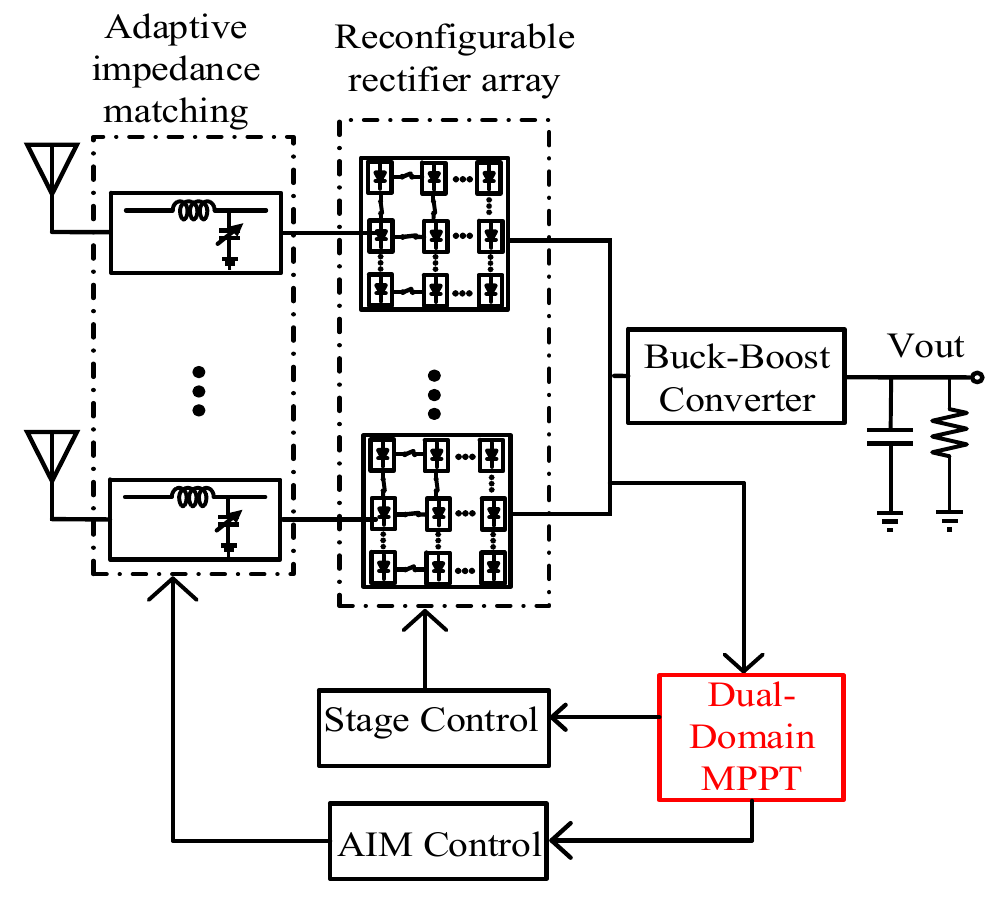
Figure 2. The proposed RF energy harvesting system.